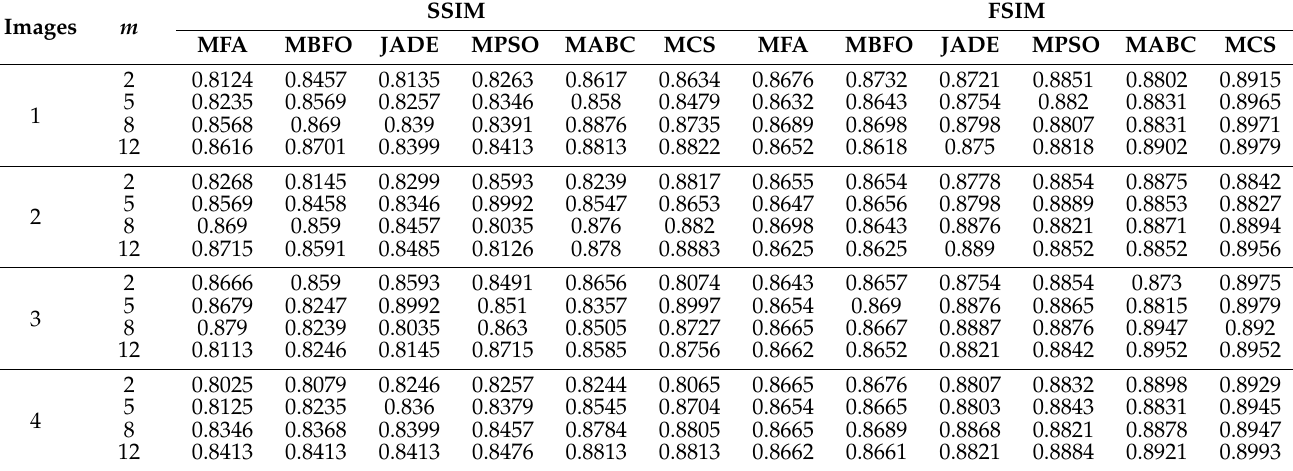
Table A5. SSIM and FSIM computed using different optimization algorithms with minimum cross entropy.